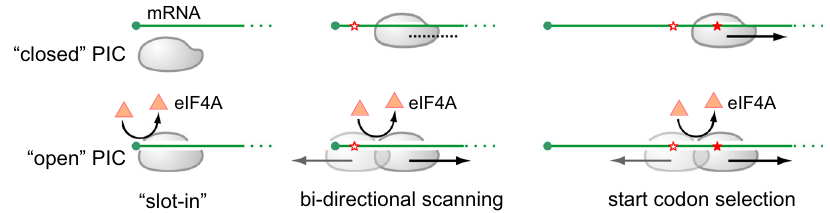
Fig. 6 Proposed models for eIF4A-mediated PIC conformational change that uni fi es ribosome recruitment, scanning, and start codon selection. In the absence of eIF4A, the closed PIC conformation leads to reduced mRNA loading, delayed PIC scanning, and increased stringency of start codon selection. In the presence of eIF4A (orange triangle), multiple cycles of ATP hydrolysis lead to open conformation of PIC that facilitates slot-in mRNA loading, bi- directional PIC scanning, and selection of suboptimal start codons (empty red